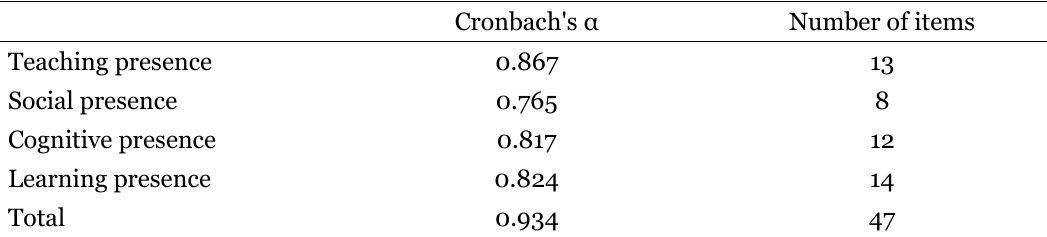
Reliability of the